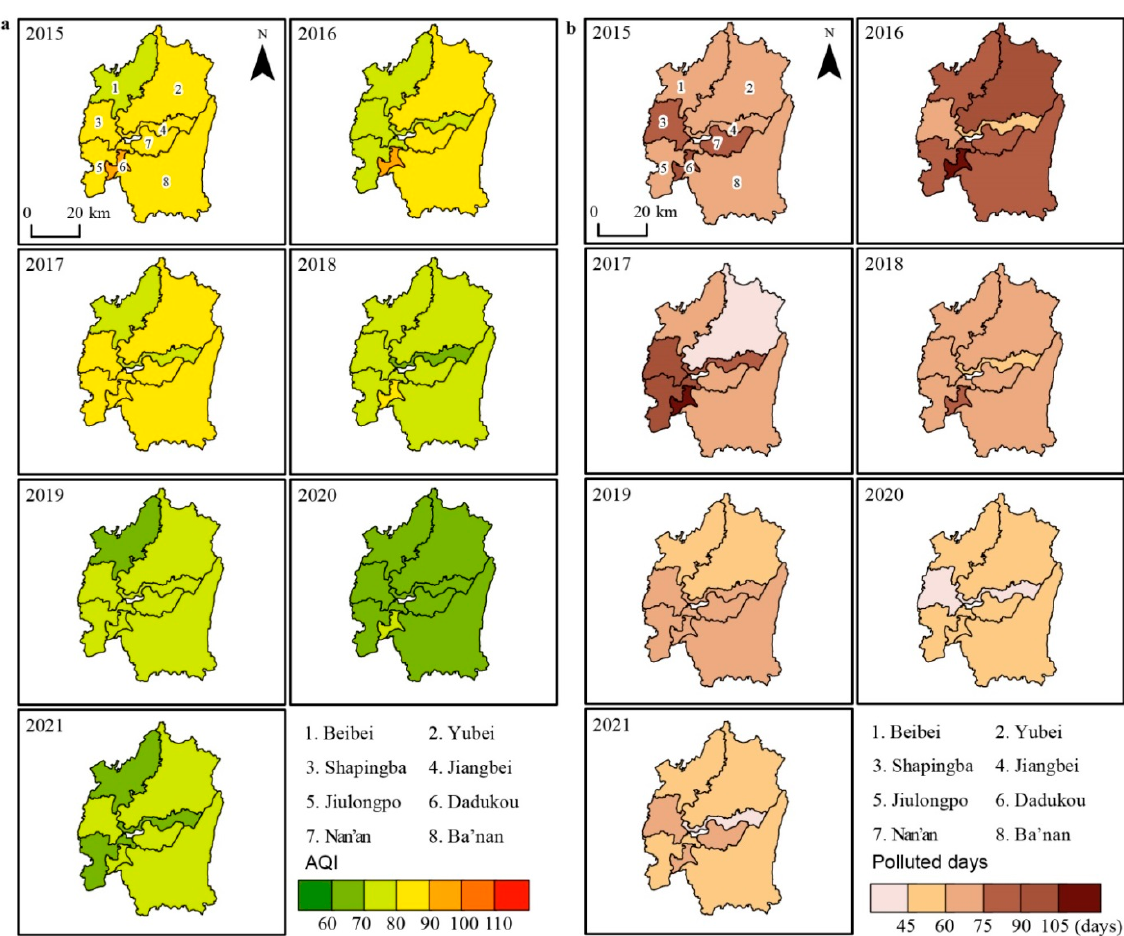
Figure 8. Spatial heterogeneity of annual AQI ( a ) and polluted days ( b ) from 2015 to 2021.